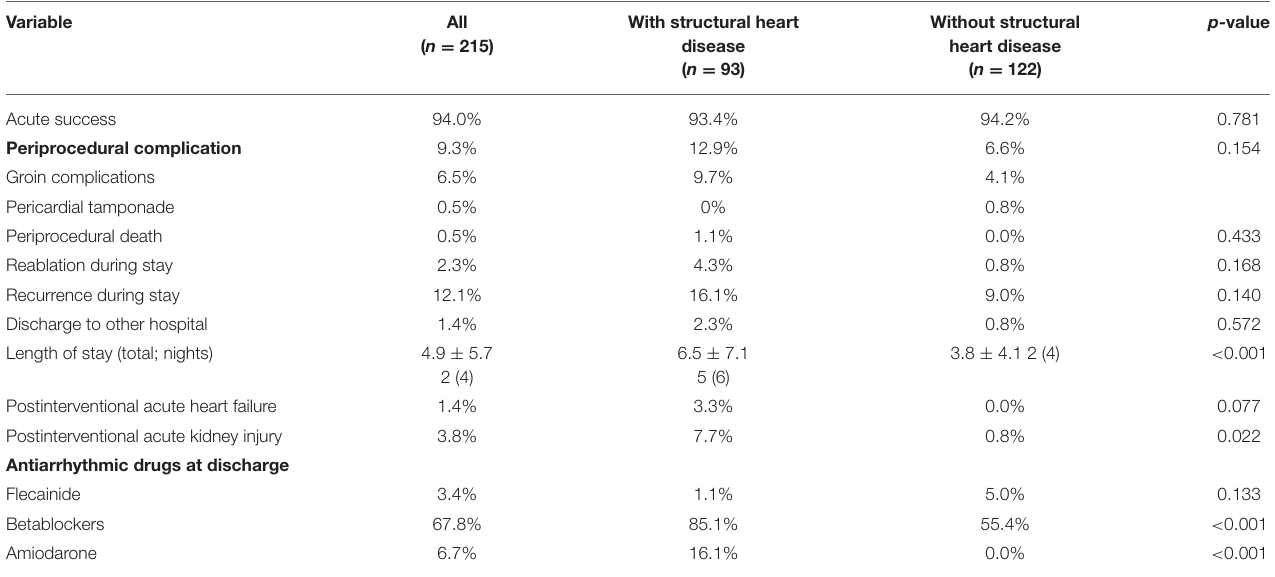
TABLE 3 | Acute outcome of patients with outflow tract arrhythmias.